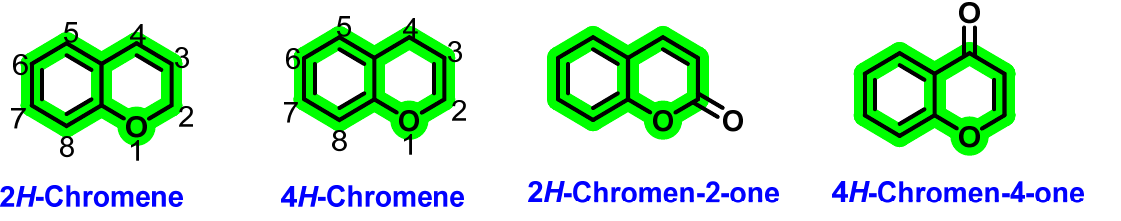
Figure 3. Structure of different chromene scaffolds.